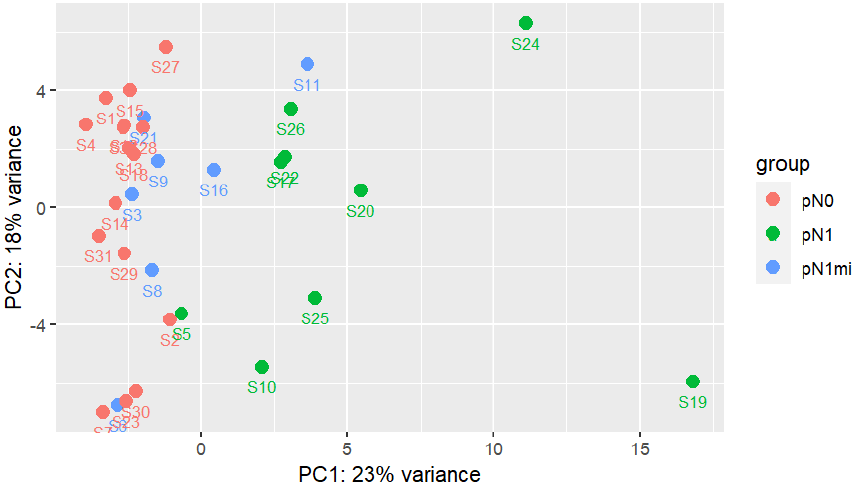
Figure 1. First two principal components analysis with all genes and samples. Each group of sam- ples has a specific color. DESeq2 regularized logarithm data transformation (rlog) was used as input